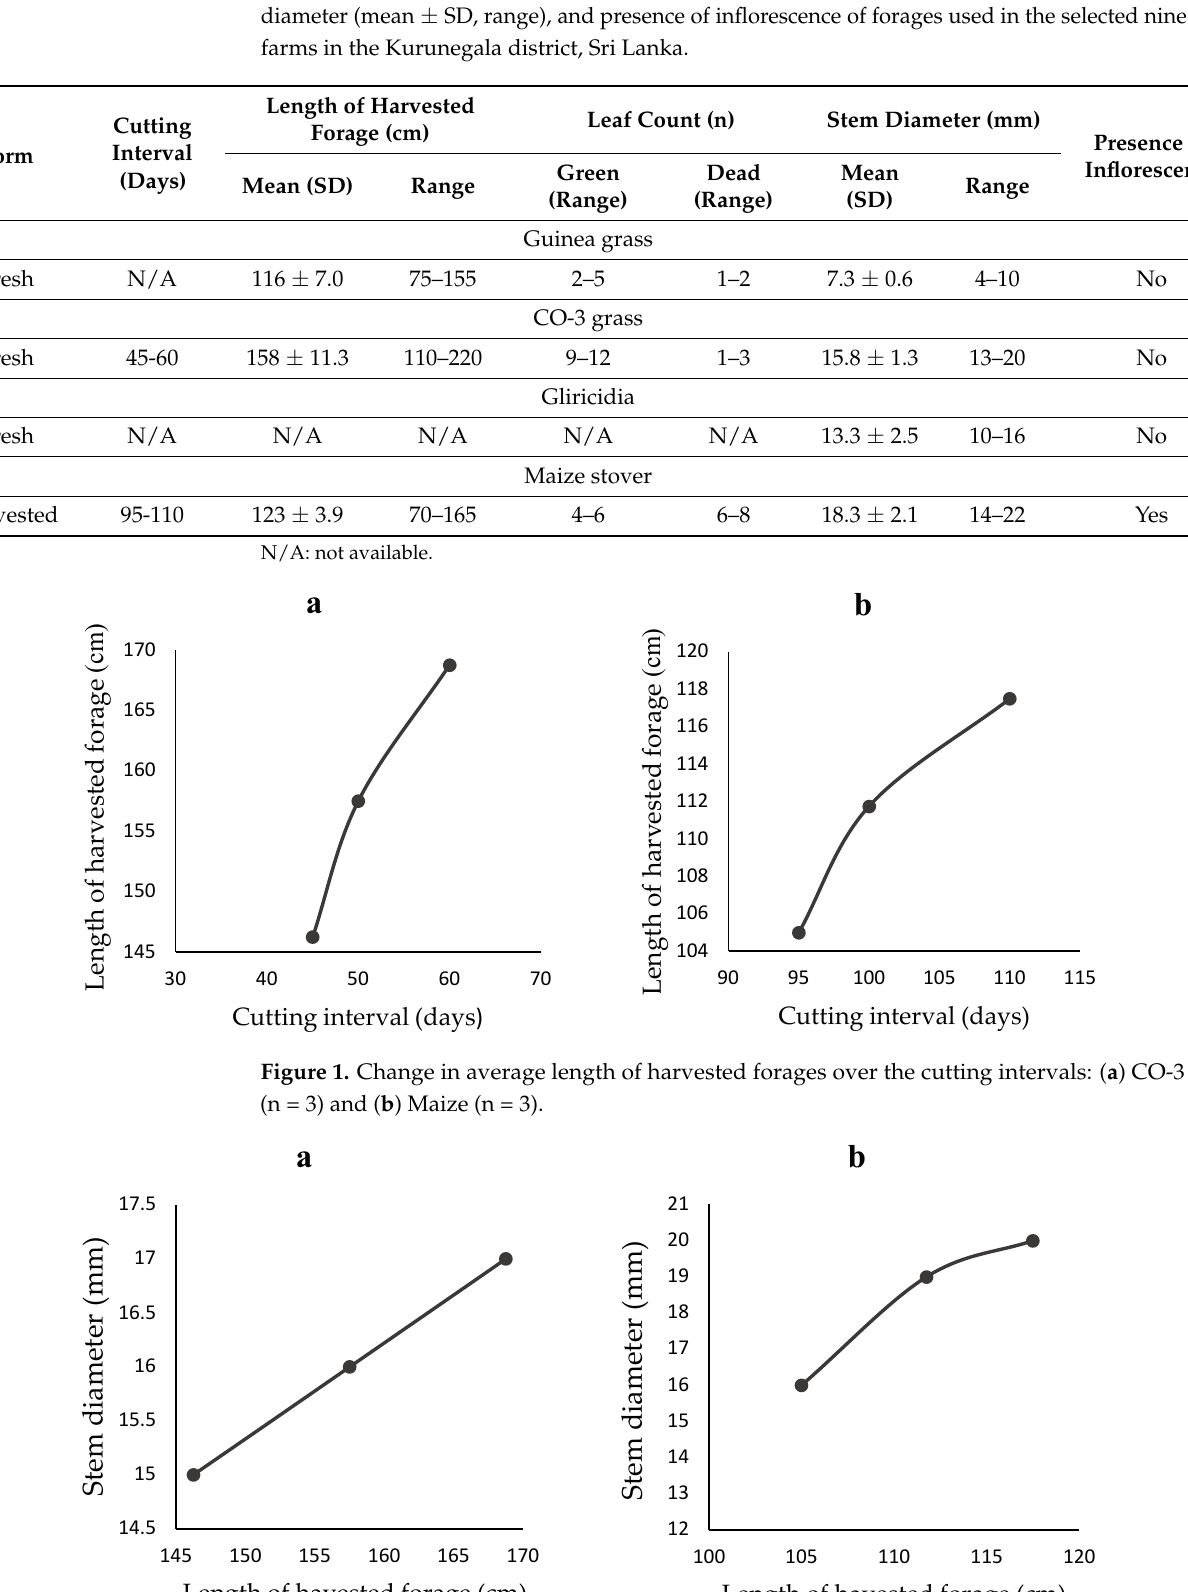
Figure 2. Average change in stem diameter over length of harvested forages: ( a ) CO-3 grass (n = 3) and ( b ) Maize (n = 3).